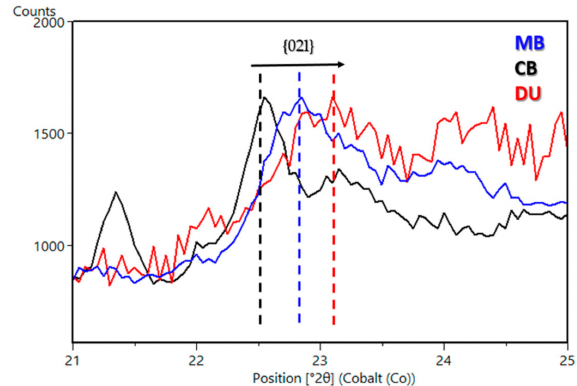
Figure 21. XRD patterns from 20–25 ◦ 2 θ of the samples CB, MB, and DU to show the position of the d(02l) peaks. The XRD patterns of these samples demonstrate a shift from trioctahedral smectite in CB to mixed trioctahedral-dioctahedral smectite in MB to a fully dioctahedral smectite in DU. These shifts in the d(02l) peak represent environmental changes that are reflected in the phyllosilicates present in Gale